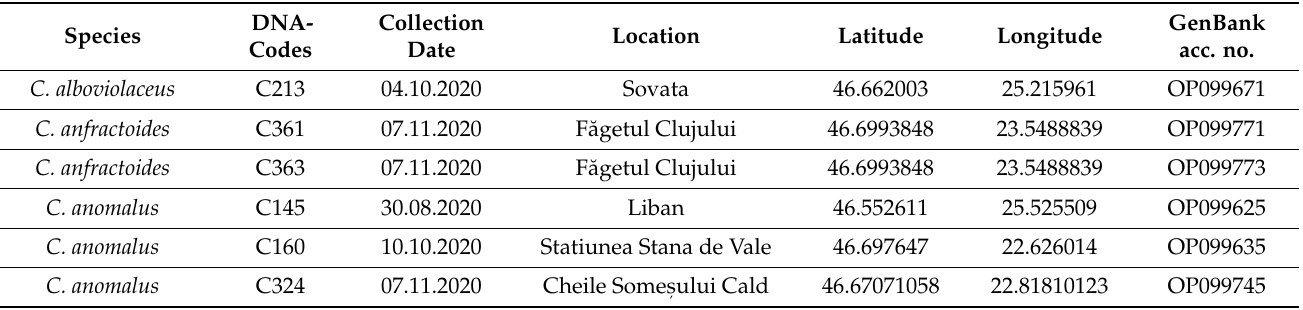
Table 1. Metadata of Cortinarius samples studied and identified during this work. All sequences are newly